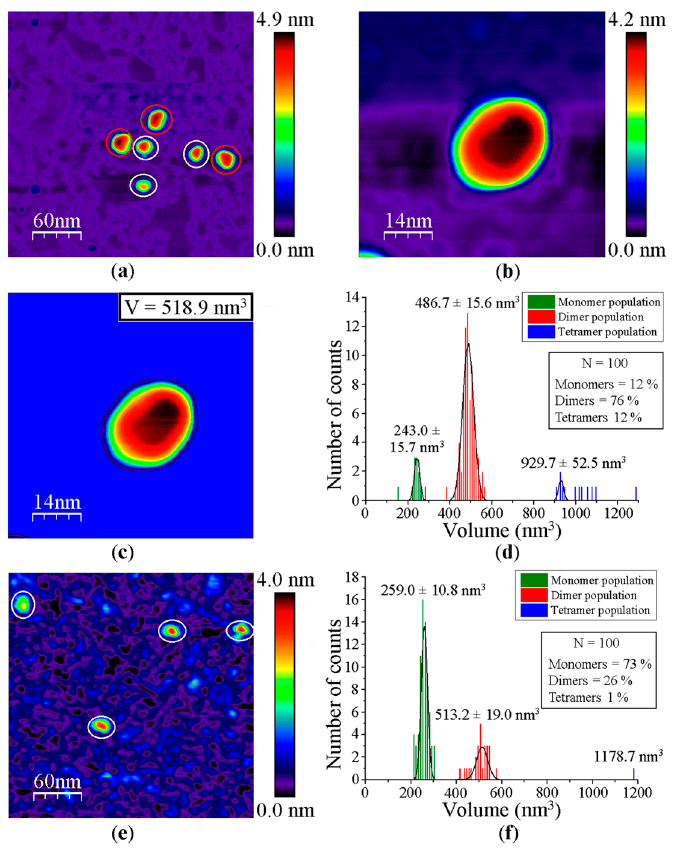
Figure A4. Steps for the calculation of feature volumes using as a model of study the impact of detergent molecules on the oligomerization state of GvDDOR. Data are related to GvDDOR ( a – d ) in the absence and ( e , f ) presence of detergent molecules. ( a ) AFM topography image of GvDDOR.